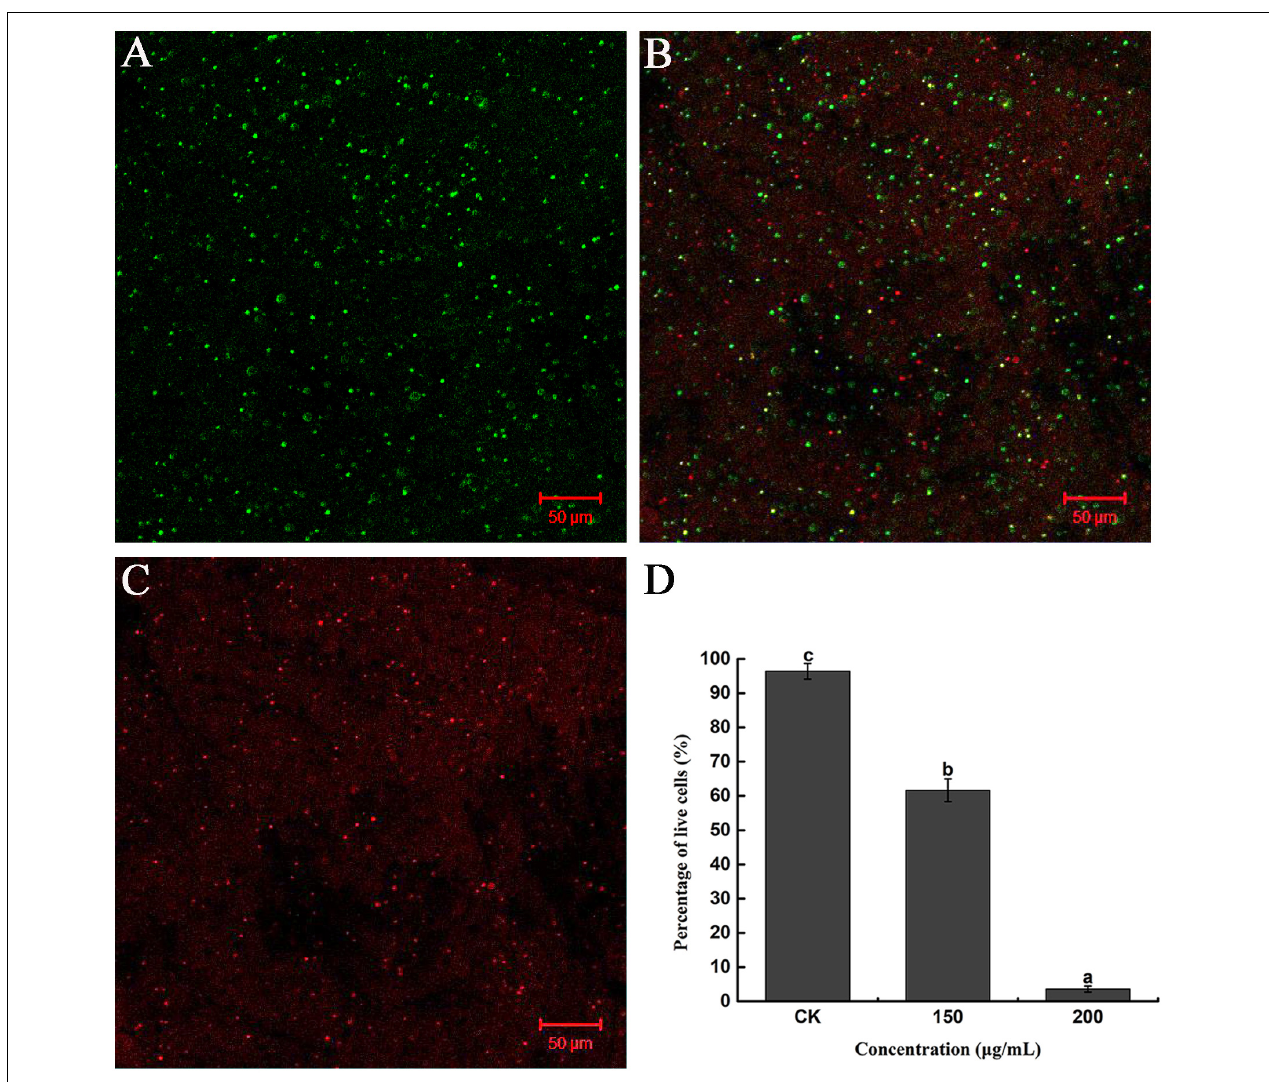
FIGURE 4 | Fluorescence microscope image of R. solanacearum cells treated with caffeic acid. (A–C) Confocal fluorescence microscopic images were obtained using the LIVE/DEAD BacLight Bacterial Viability and Counting Kit and treatment with caffeic acid at 0, 150, and 200 µ g/mL concentrations, respectively. (D) The percentage of live cells supplemented with caffeic acid after incubation for 10 h. Error bars indicate the standard deviation and different letters indicate significant differences between caffeic acid treatment and control ( P < 0.05, Duncan’s